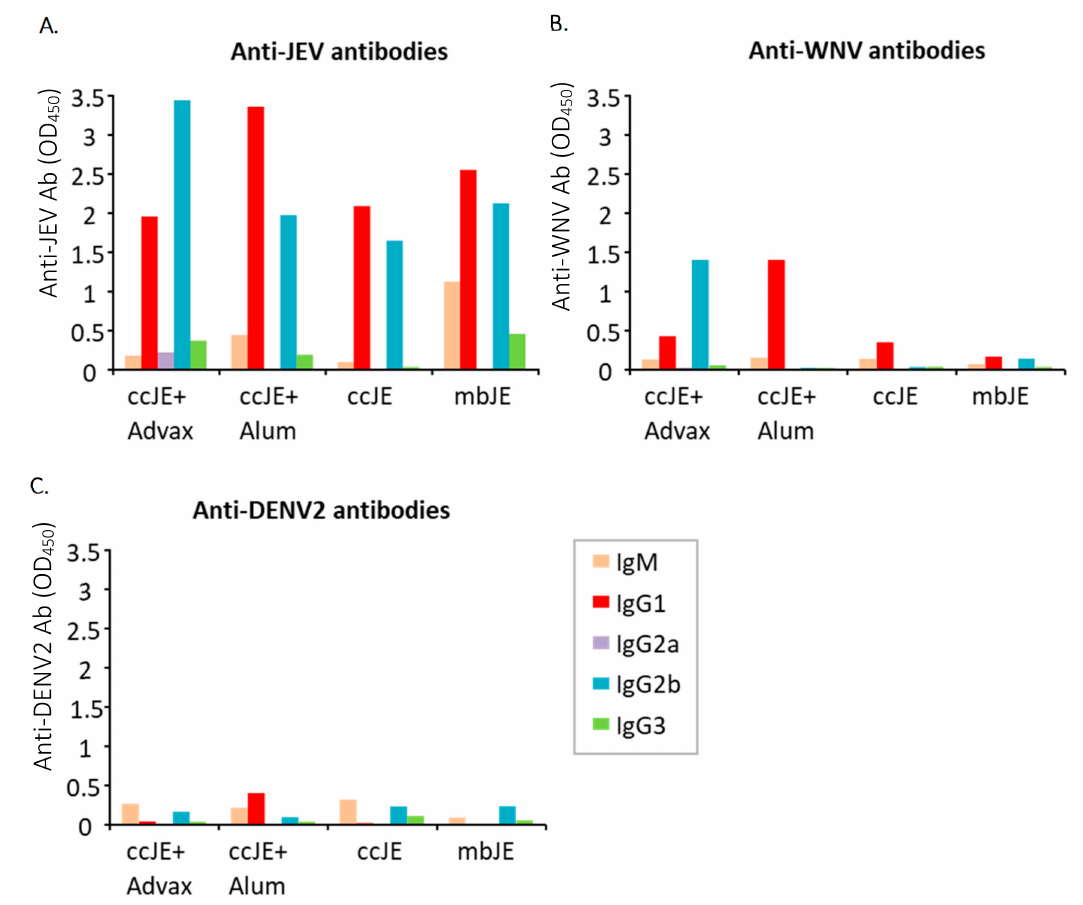
Figure 1. Advax induces a Th1-dominant antibody response. C57BL/6 ( n = 10/group) were immunised and boosted after 3 weeks with ccJE (50 ng) or mbJE (50 ng) alone or with Advax (1 mg) or alum (30 µ g). Blood was collected 3 weeks post last immunisation and antigen-specific antibody titres against ( A ) JEV, ( B ) WNV and ( C ) DENV2 were determined by ELISA using isotype/subclass-specific antibodies on pooled serum for each group and are shown as OD values at 450 nm. Table 2. Advax induces a high IgG2b/IgG1 antibody ratio that is maintained in IFN- γ KO mice. C57BL/6 ( n = 10/group) and IFN- γ KO ( n = 5/group) mice were immunised and boosted after 3 weeks with ccJE (50 ng) or mbJE (50 ng) alone or with Advax (1 mg) or alum (30 µ g). Blood was collected 3 weeks post last immunisation and antigen-specific antibody titres against JEV, WNV and DENV2 were determined by ELISA using isotype/subclass-specific antibodies on pooled serum for each group and are shown as IgG2b/IgG1